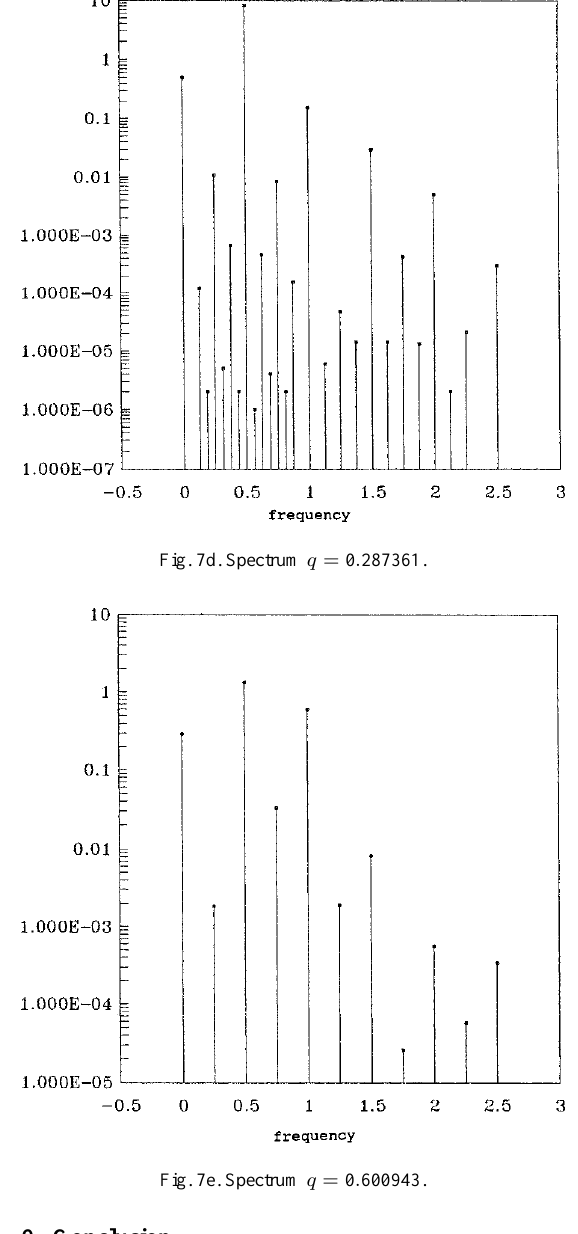
Fig. 7e. Spectrum q = 0 :